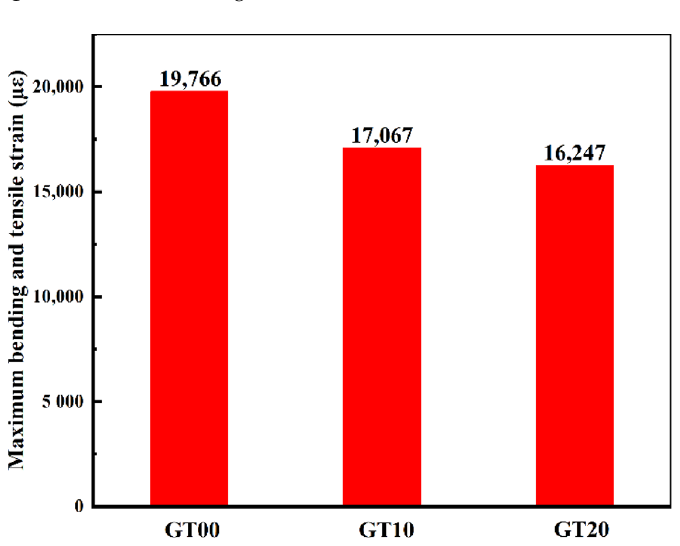
Figure 17. Maximum bending and tensile strain.